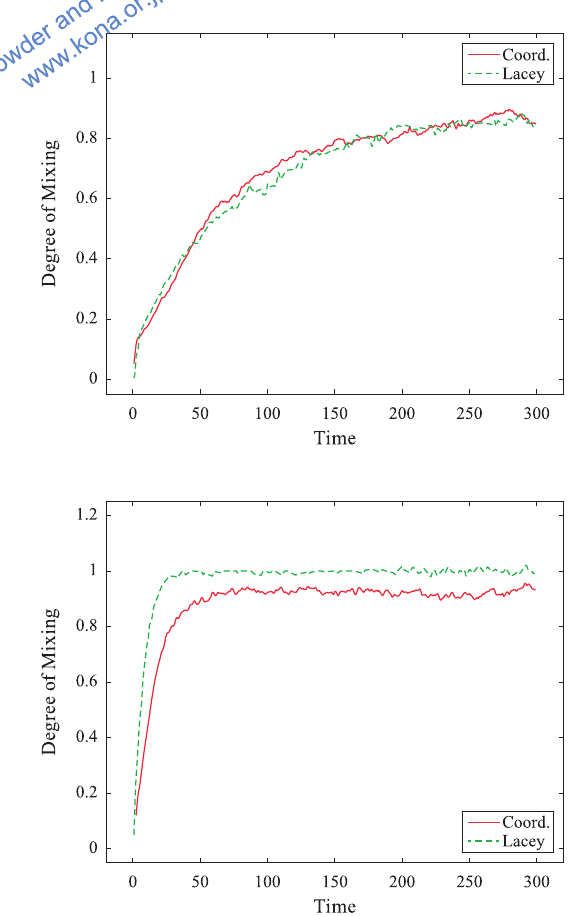
Fig. 10 Comparison of time evolution of mixing degree for the case where (a) Γ = 3, f = 20 Hz and the electro- static force does not exist; and (b) Γ = 5, f = 20 Hz, but electrostatic force does exist. The dimensionless ac- celeration amplitude Γ was defined as Γ = a / g , where a is the acceleration; g was the acceleration due to gravity. The vibrational frequency is f